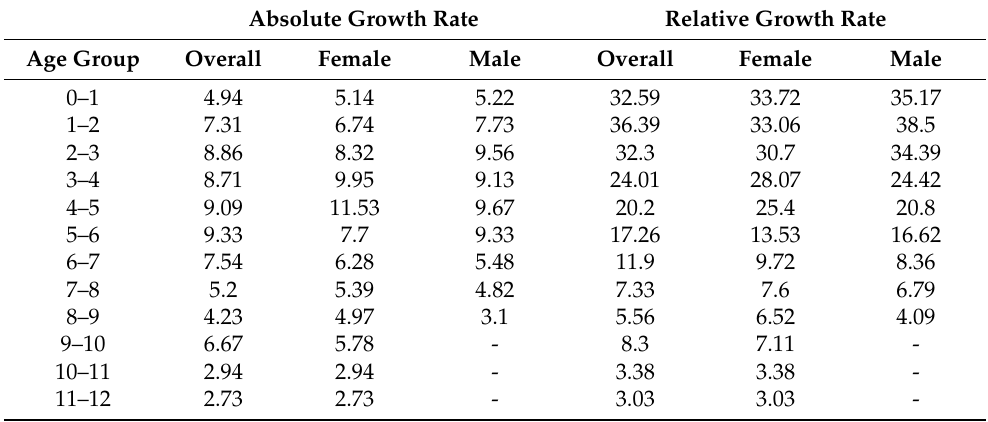
Table 4. The relative and absolute growth rates of for Dipturus oxyrinchus inhabiting the Northeastern Mediterranean